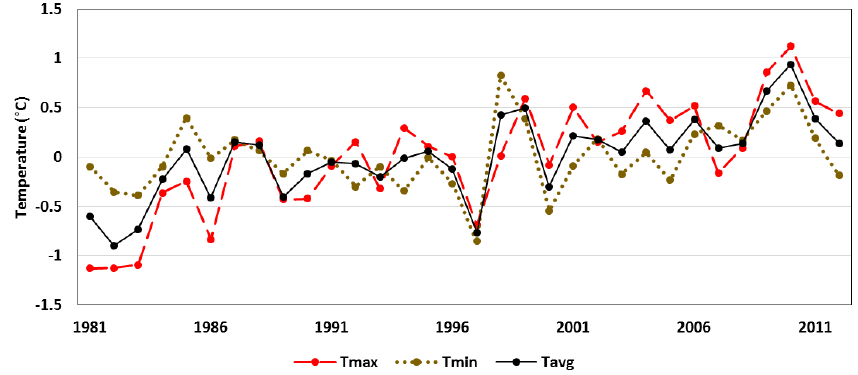
Figure 7. Average annual maximum, minimum, and mean temperature anomaly of the KRB.